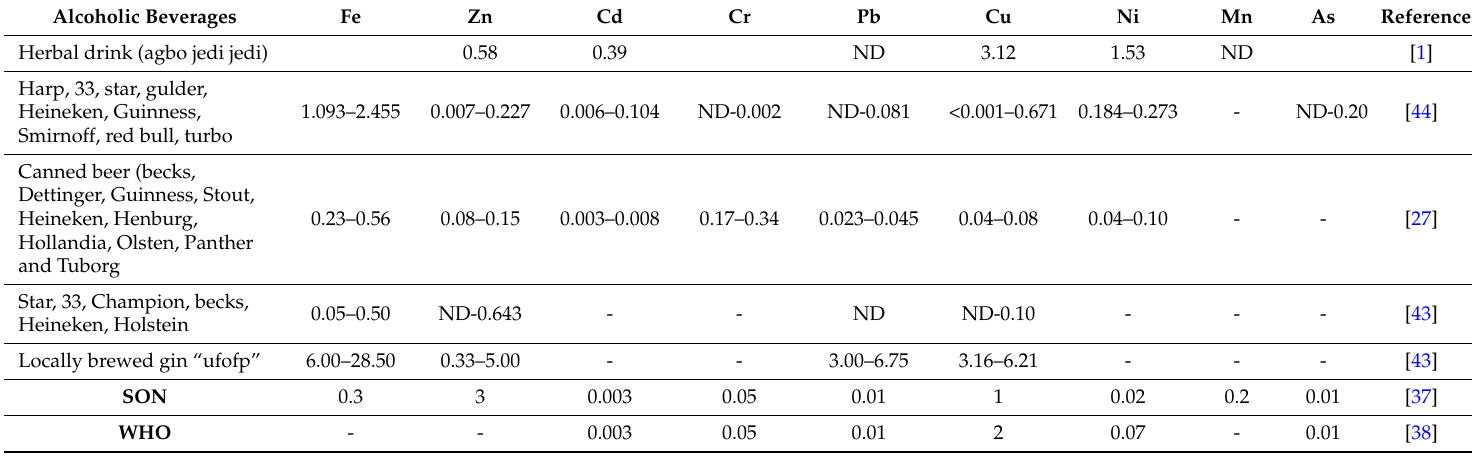
Table 2. Heavy metal (mg/L) concentration in some alcoholic beverages consumed in